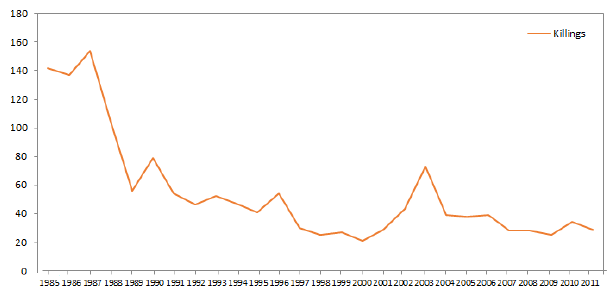
Figure 4. People killed over land disputes, 1985–2011. Source: Based on [16].